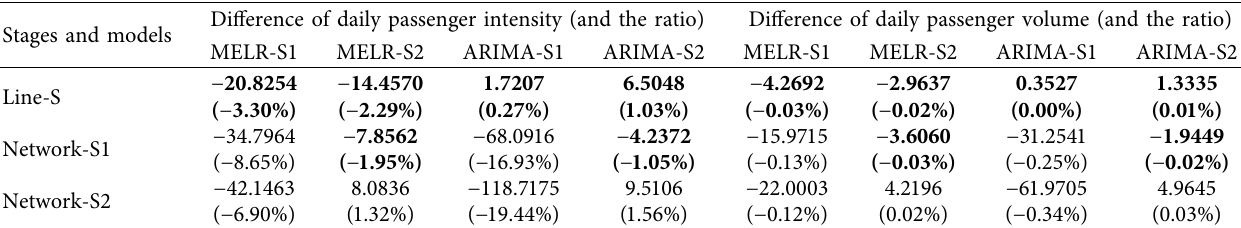
Note. The bold text indicates the fitting value and the normal text indicates the predicted value. Values in parentheses indicate the ratio of the accumulated difference to the true intensity or